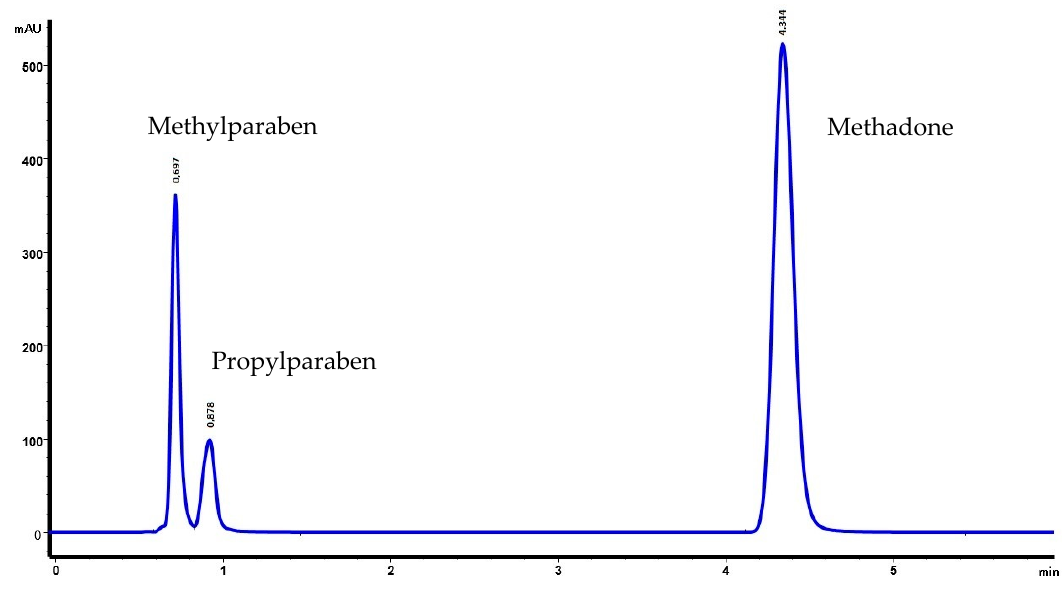
Figure 2. Chromatogram of methadone hydrochloride (10 mg/mL) with preservatives (M2). Reten- tion times for methadone, methylparaben, and propylparaben were 4.344, 0.697, and 0.878 min. The method was linear (y = 284.3x − 97.8, r = 0.996), with y being the obtained areas